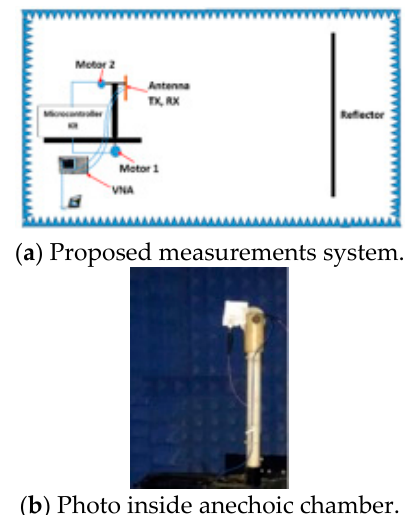
Figure 7. Setup system for VAA measurements.